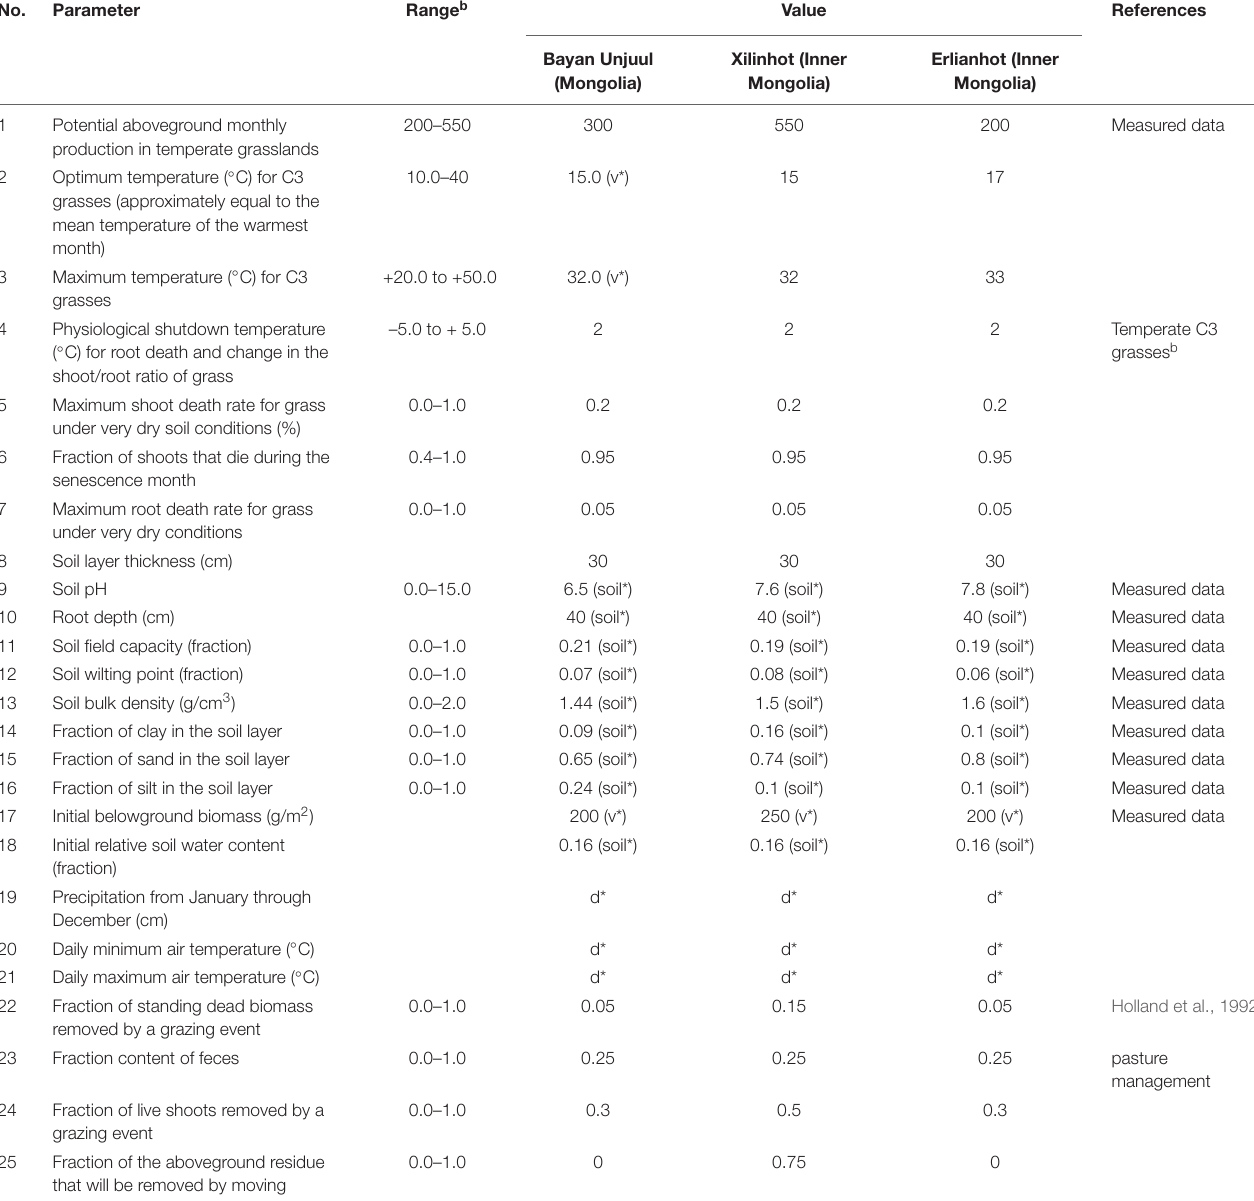
TABLE 1 | DAYCENT model input parameters for Mongolian and Inner Mongolian TGs a